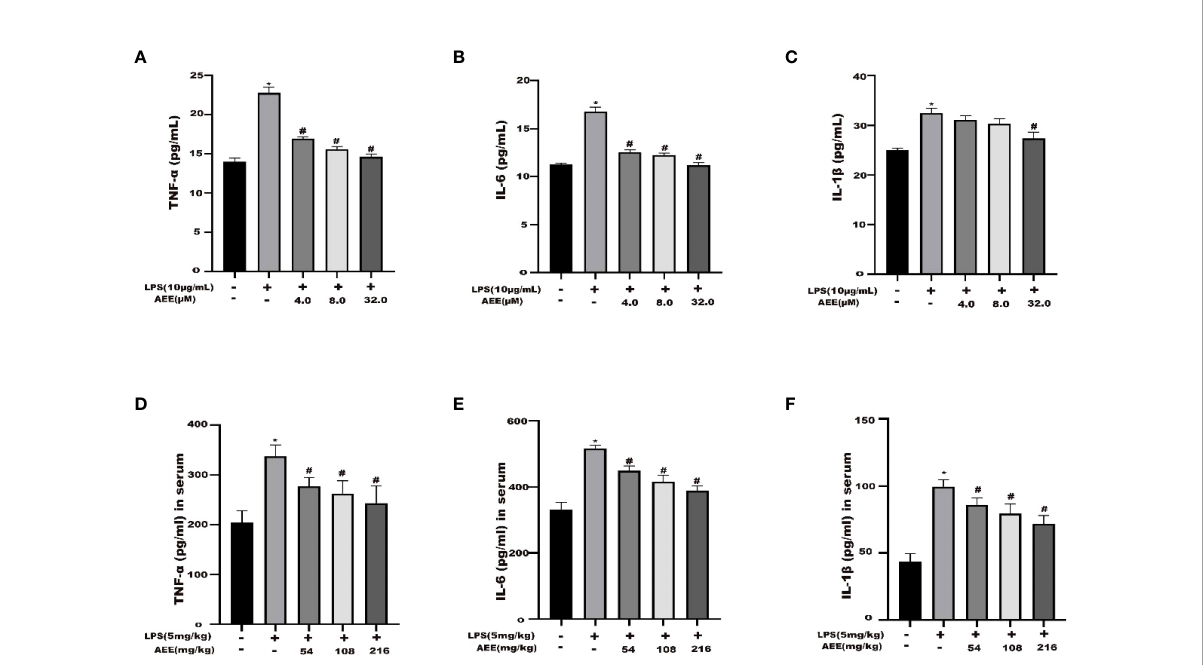
FIGURE 2 Effect of AEE on LPS-induced in fl ammatory cytokines. (A) TNF- a , (B) IL-6 and (C) IL-1 b in the supernatant of A549 cells. (D) TNF- a , (E) IL-6, and (F) IL-1 b in the serum of LPS-induced ALI rats. Values are presented as the means ± SD where applicable ( n = 6). * P < 0.05 compared to control group, # P < 0.05 compared to LPS group.